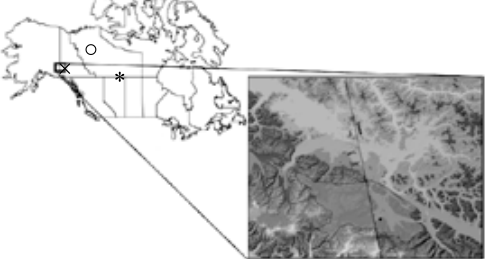
Fig. 1. Map of the Chisana caribou range expand- ing from the Wrangle-St. Elias mountain range of Alaska, USA into the south west corner of the Yukon, Canada. Location of the temporary en- closure at Boundery Lake, Yukon (61°39’00’’N, 140°50’25’’ W) indicated by the black circle. Lo- cations of Haines Junction, YT ( × ), Forth Smith, NT ( ∗ ), and Lennie Lake, NT (  ) also indicated on map. (Reproduced with permission from Layne Adams and Gretchen Roffler, USGS - Alaska Sience